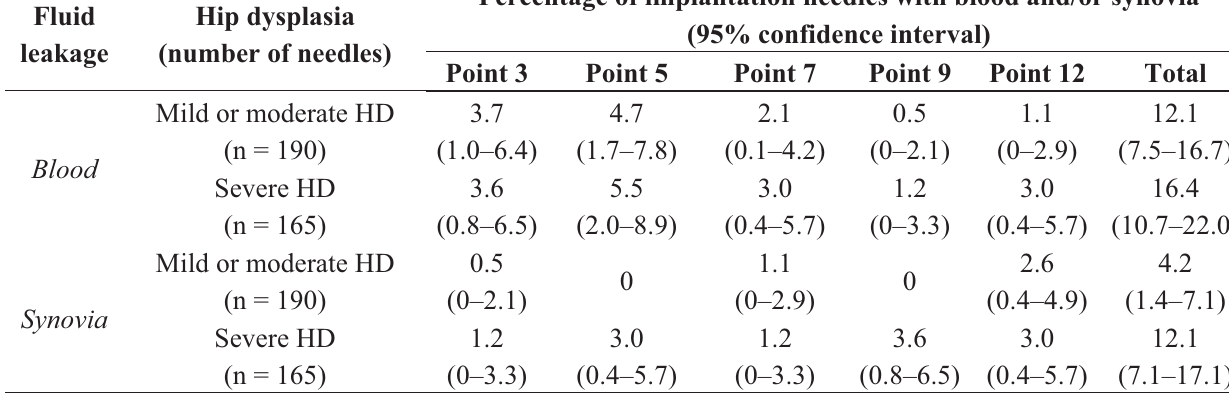
Table 2. The percentage of blood and synovia leakage from the needles during implantation of gold beads at five acupuncture points (Point 3–12, see Figure 1) around the hips of 38 dogs with hip dysplasia (HD). The percentage is calculated as the number of observations divided by the total number of needles multiplied by 100 (N = 355).